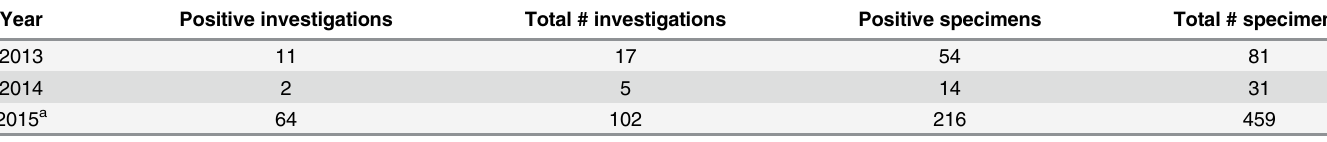
Table 4. U.S. vesicular investigations diagnosed to be positive for SV-A via qRT-PCR by FADDL, 2013 –